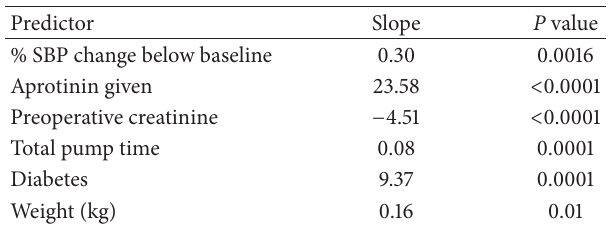
Table 3: Single hypothesis test in the validation dataset. Multivari- able linear regression model showing association between % change in SBP and percent delta